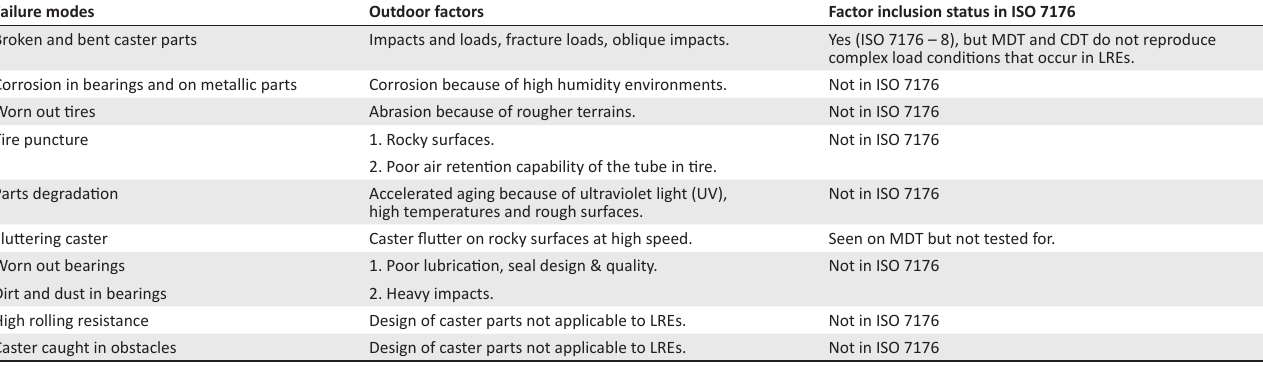
TABLE 1: Caster assembly failure modes and corresponding quality-affecting factors as seen in the field. Failure modes Outdoor